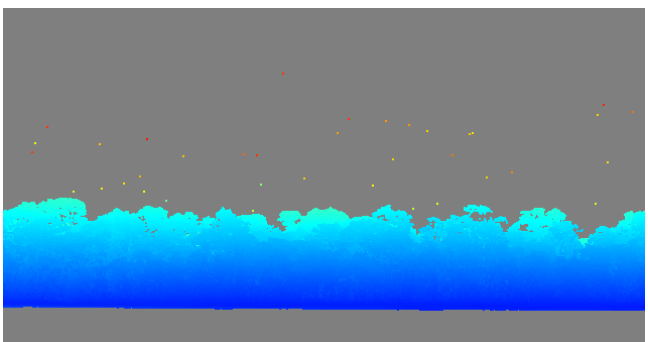
Figure 7. Close-up of a region of the 3D cloud point data that shows presence of outliers above the trees. It is colored by height values, from blue to red.